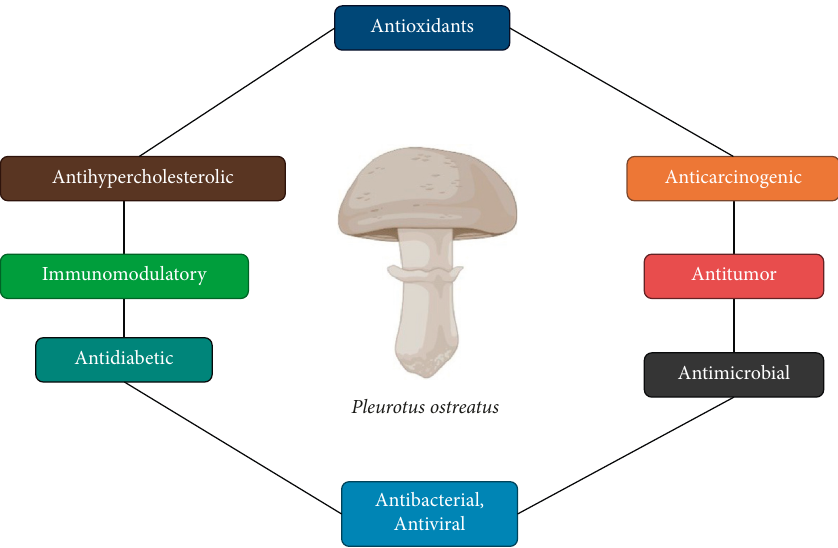
Figure 2: Medicinal properties and pharmacological potentiality of P. ostreatus . Table 2: Medicinal properties and pharmacological potentiality of P. ostreatus